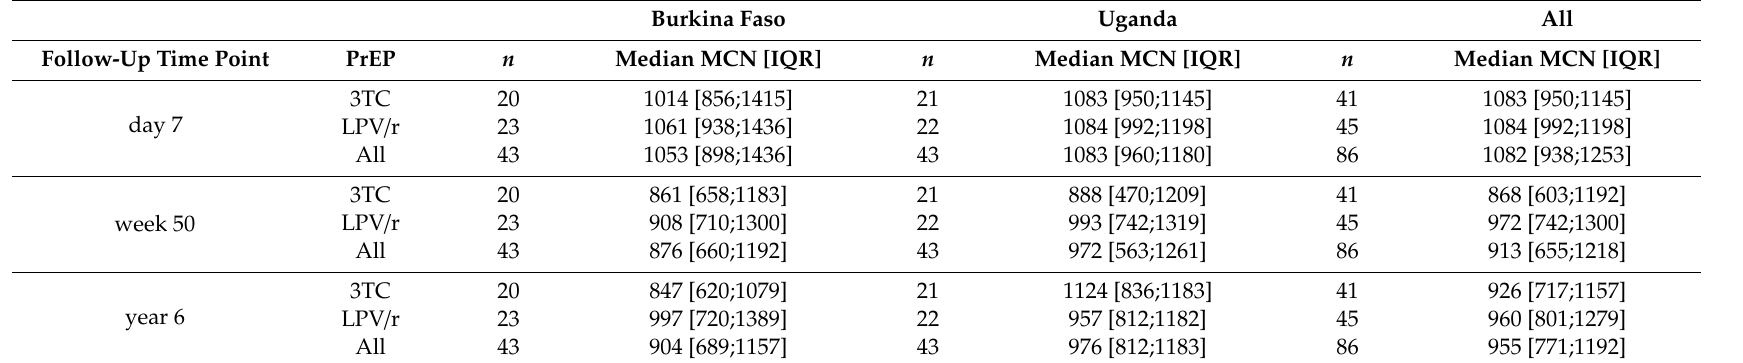
Table 2. Mitochondrial DNA content at baseline, week 50, and year 6. Burkina Faso Uganda